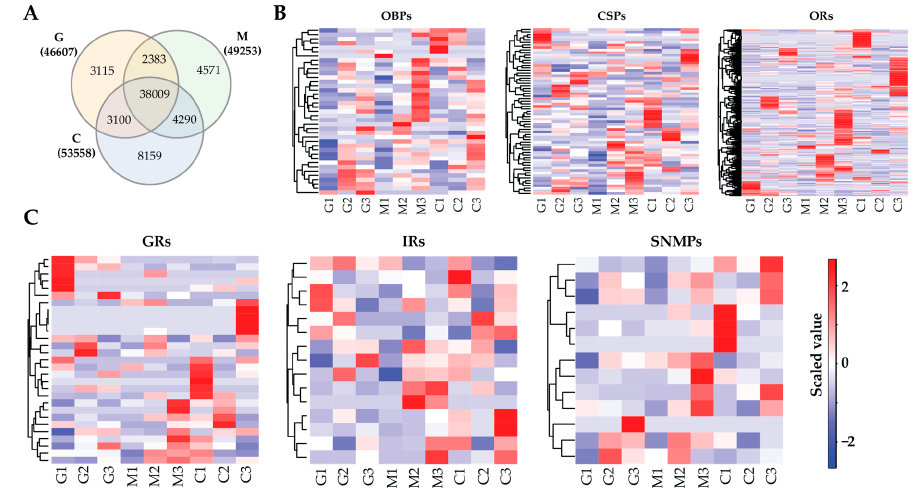
Figure 2. Expression levels of olfactory transcripts in the Ashmead insects. ( A ) Number of transcripts identified in the insects stimulated by three fruits. ( B ) Heat maps of the expression levels of OBP, CSP, and OR transcripts. ( C ) Heat maps showing the expression levels of transcripts encoding GRs, IRs, and SNMPs in the Ashmead